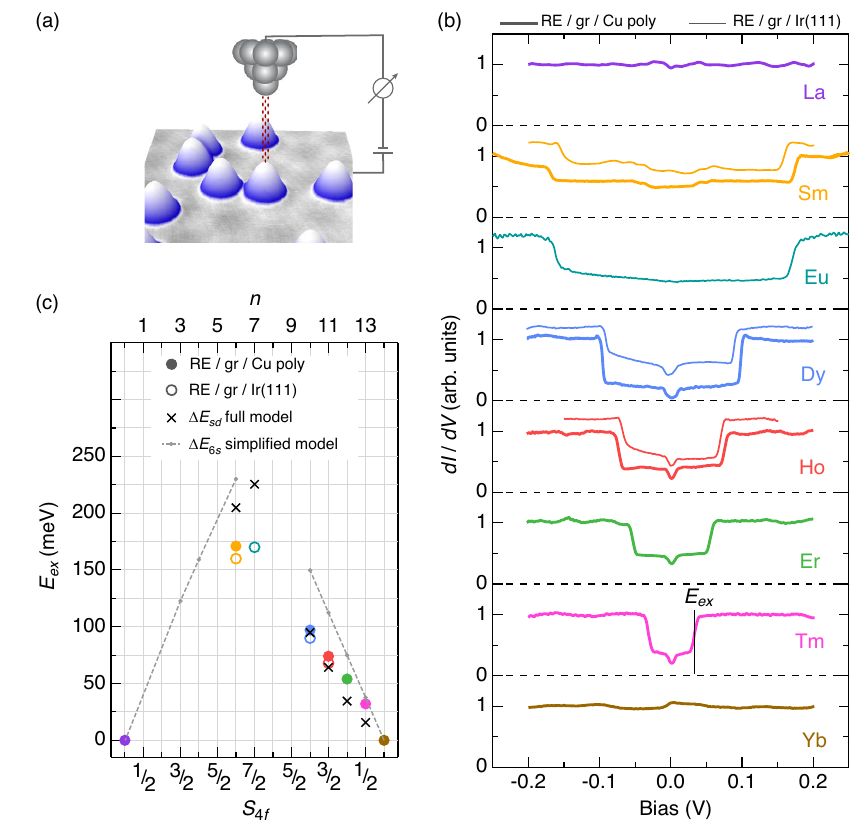
FIG. 1. IETS spin excitations originating from breaking the intra-atomic exchange interaction. (a) 3D rendering of a constant current ¼ − 0 . 5 V, I ¼ 30 pA, T ¼ 6 . 5 K), together with a sketch illustrating the STM STM image of Dy atoms on gr = Ir ð 111 Þ ( V t t measurements. (b) Conductance spectra acquired on La, Sm, Eu, Dy, Ho, Er, Tm, and Yb single atoms adsorbed on gr/polycrystalline copper (thick lines) and on gr = Ir ð 111 Þ (thin lines). The IETS excitation corresponding to breaking the intra-atomic exchange is labeled E on the Tm spectrum as an example. Each spectrum is the average of about ten spectra acquired on different atoms. Spectra are ex background corrected and normalized to 1. Spectra on gr = Ir ð 111 Þ are vertically offset by 0.3 for clarity. Spectroscopy parameters: ¼ 200 pA, V ¼ − 0 . 2 V for all spectra except for Sm on gr = Cu and Eu on gr = Ir ( V ¼ − 0 . 25 V), and for Ho on gr = Ir I set set set ¼ − 0 . 15 V), V ¼ 5 mV peak-to-peak, T ¼ 6 . 5 K. All spectra are acquired using a W tip. (c) E ( V vs S 4 , the spin angular f set mod ex momentum of the 4 f shell, and n , the number of f electrons. The error bar is of the order of (cid:2) 1 meV, i.e., smaller than the size of the symbols, and corresponds to the width of the observed energy distribution. Calculated values of the excitation energy Δ E obtained with simplified and full models are also reported (see